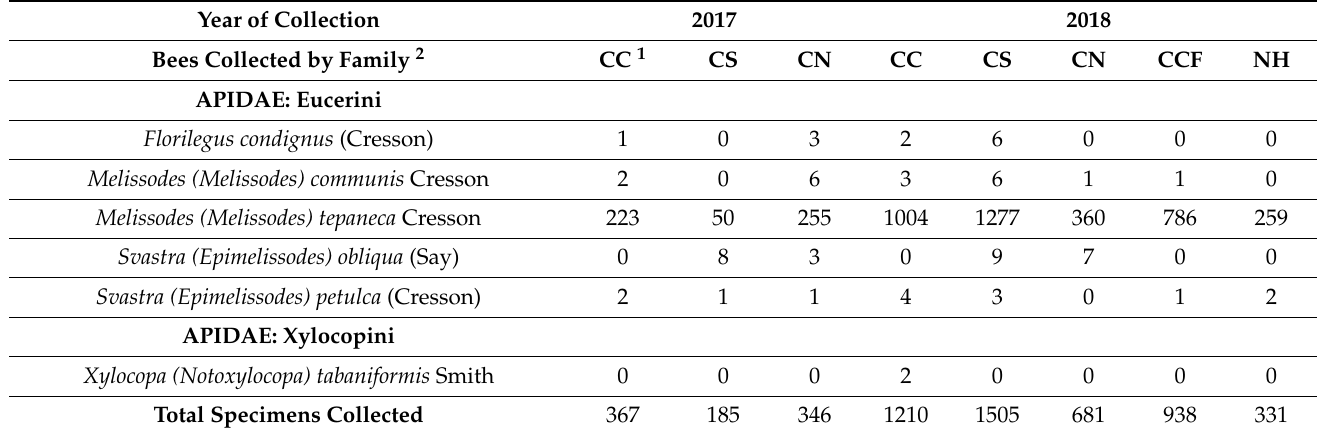
Figure 2. Species accumulation curves from bee bowl collections conducted in 2017 ( a ) and combined 2017 and 2018 ( b ) across crop and semi-natural habitat interfaces in a large-scale cotton agroecosystem.